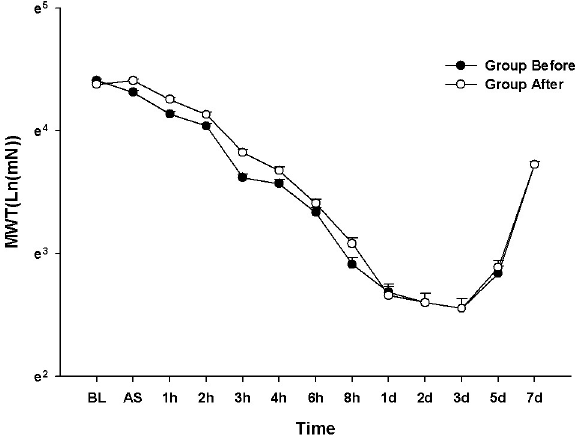
Fig 4. Evaluation of analgesic effect according to time of administration: Before vs. after test. The graphs are presented as means ( ± standard error of the mean) of the mechanical withdrawal threshold with von Frey filaments. Mechanical withdrawal threshold with von Frey filaments. BL: baseline, AS: after